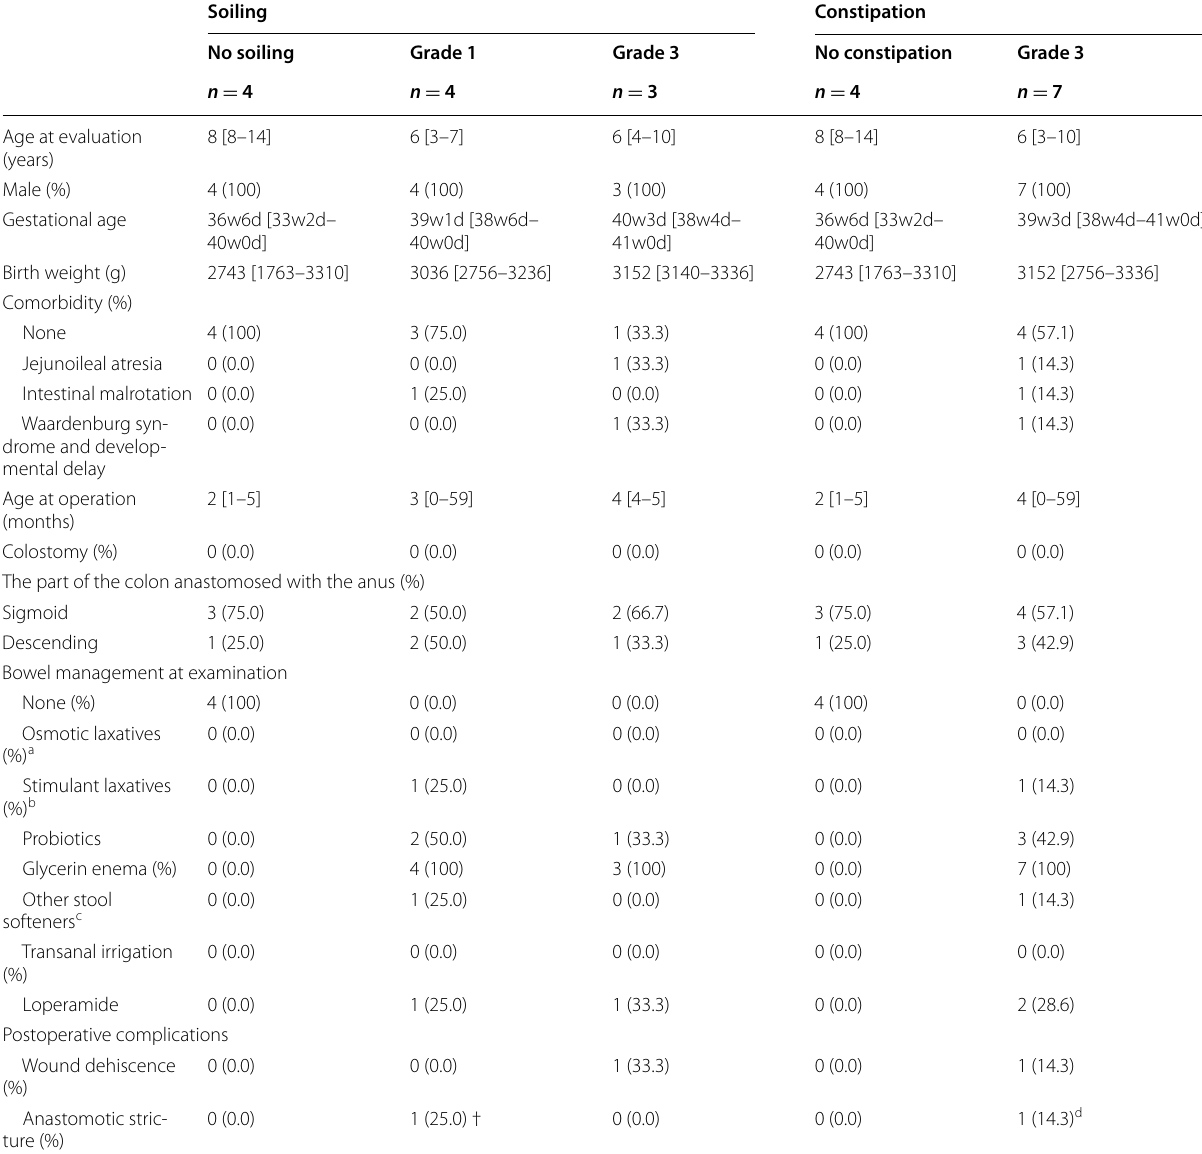
Table 2 Patient characteristics and anal function